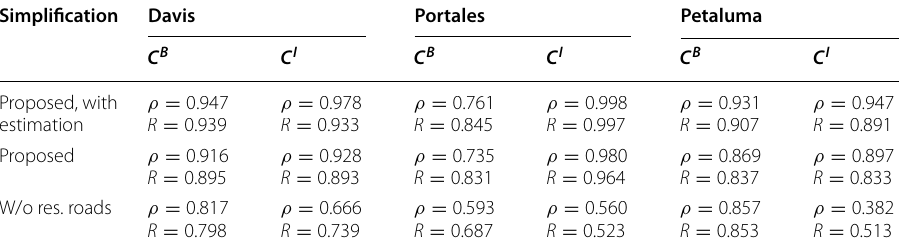
Table 3 Pearson ( ρ ) and Spearman ( R ) correlation coefficient between centrality measurement of original and simplified networks Simplification Davis